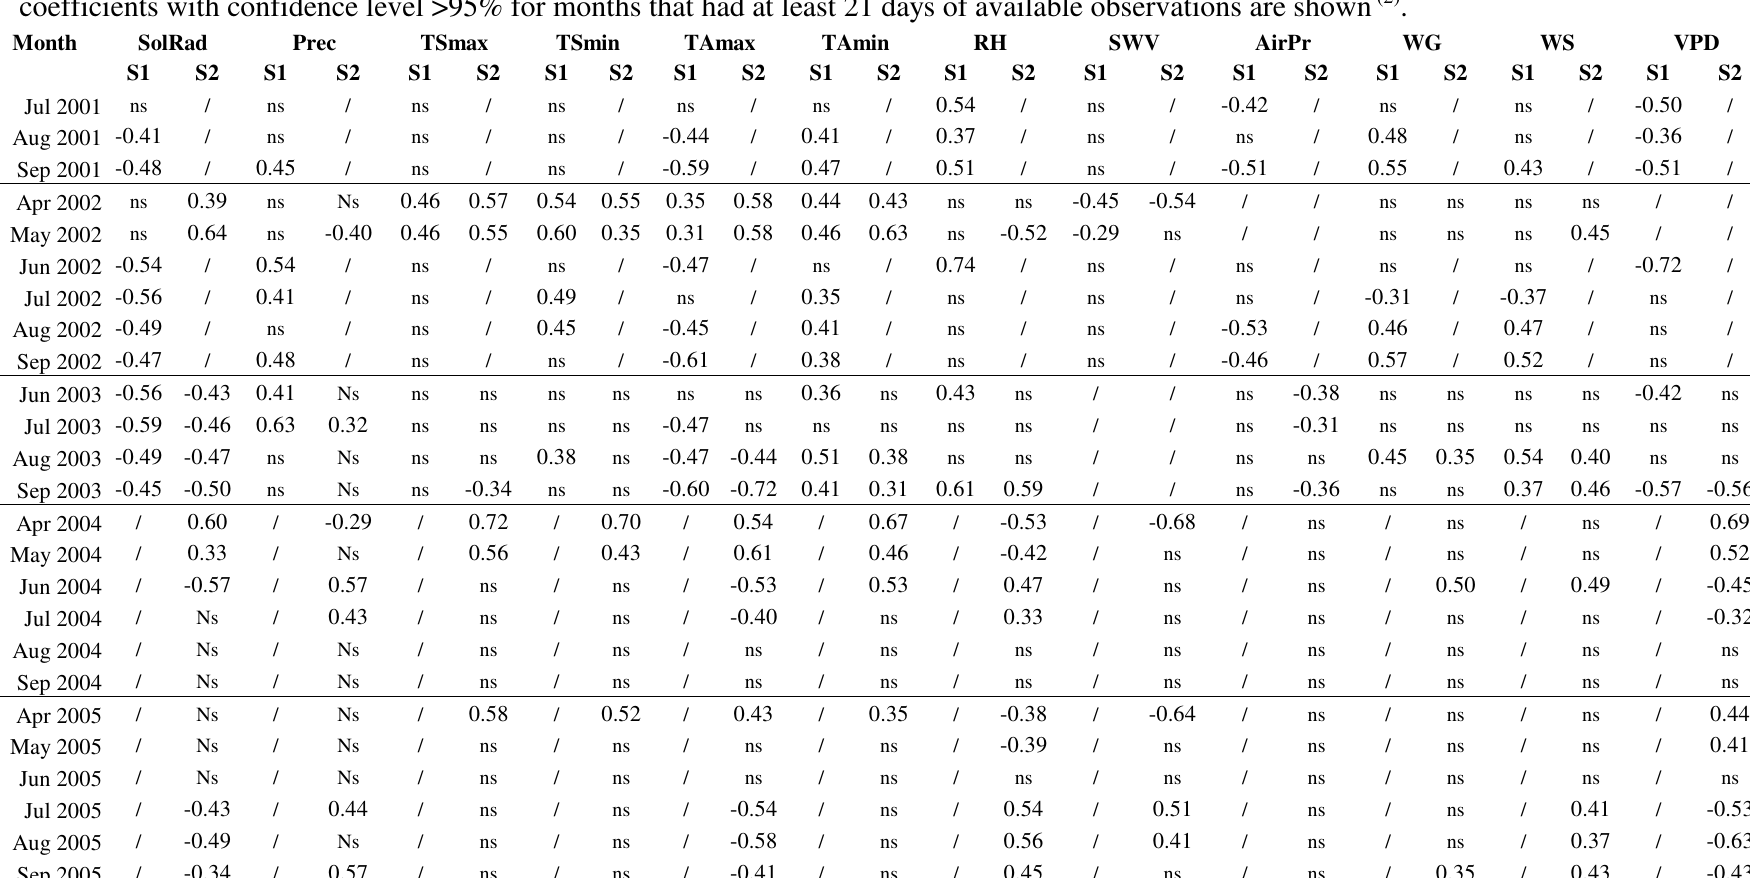
Table 1. Bootstrapped linear correlations between daily stem radial increment (SRI; S1 = Dendrometer Site 1; S2 = Dendrometer Site 2) and daily environmental variables (1) measured by the automated weather station during the April-September growing season. Only coefficients with confidence level >95% for months that had at least 21 days of available observations are shown (2)